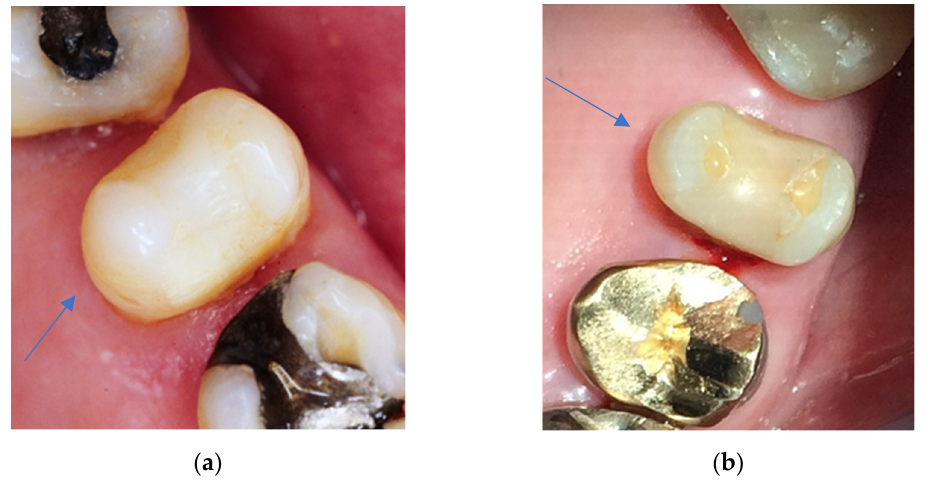
Figure 4. ( a ) Clinical view of a Herculite XRV restoration at first follow-up examination (25 mod). Twelve months after placement, the criteria anatomical form, marginal adaptation, tooth integrity, and surface luster did not score excellent but only good grades (grade 2). ( b ) Clinical view of the Herculite XRV restoration displayed in Figure 4a after 24 years in situ. Marginal fractures with exposed dentin are apparent; therefore, the restoration was clinically unsatisfactory (grade 4) in the criteria of marginal adaptation and had to be repaired. The aesthetic anatomical “form deviates from the norm but is aesthetically acceptable” [32] and the restoration shows a dull surface with multiple pores; therefore, anatomical form and surface luster scored only clinically sufficient/satisfactory results (grade 3).